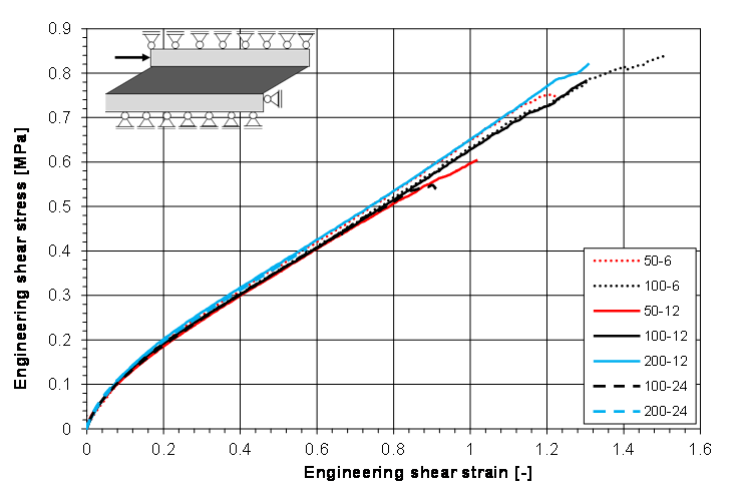
Fig. 11 Results of the shear tests – engineering shear stresses and shear strains are shown. One average curve is plotted per test series up to the average failure point for the respective series. Apart from the defined failure point, the maximum recorded load was evaluated as well. Figure 12 shows the results of failure engineering stresses and strains for the different test series (average value and standard deviation are given). For each test series, the results for failure initiation (engineering shear stress and strain) and the results for the maximum load level (engineering shear stress) are given.